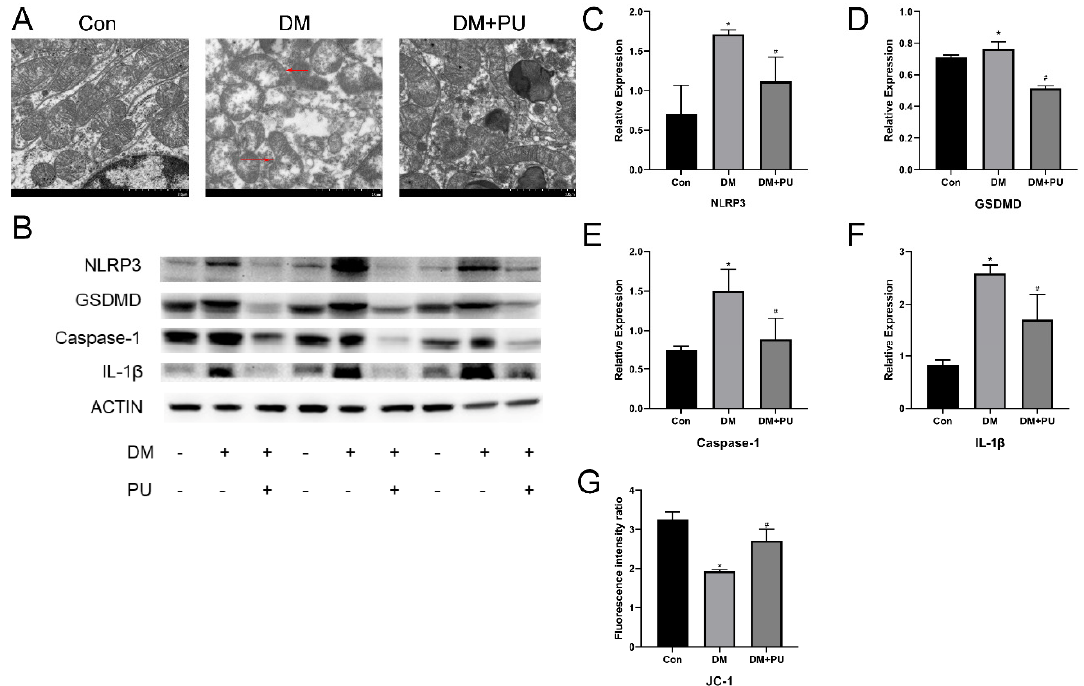
Figure 3. Effects of PU on mitochondrion injury and pyroptosis of the diabetic mice’s kidneys. ( A ) Representative image of the electron microscopy analysis, significant mitochondrial fragmentation and damage (magnification × 7000). ( B ) Protein expression levels of NLRP3 by western blotting. ( C ) Protein expression levels of GSDMD by western blotting. ( D ) The results of NLRP3, GSDMD, caspase-1, and IL-1 β by western blotting. ( E ) Expression levels of caspase-1 by western blotting. ( F ) Expression levels of IL-1 β by western blotting. ( G ) Level of mitochondrial membrane potential detected by JC-1 fluorophore. The relative expression is expressed as the ratio of the target protein to β -actin. * p < 0.05 vs. Con group; # p < 0.05 vs. DM group.